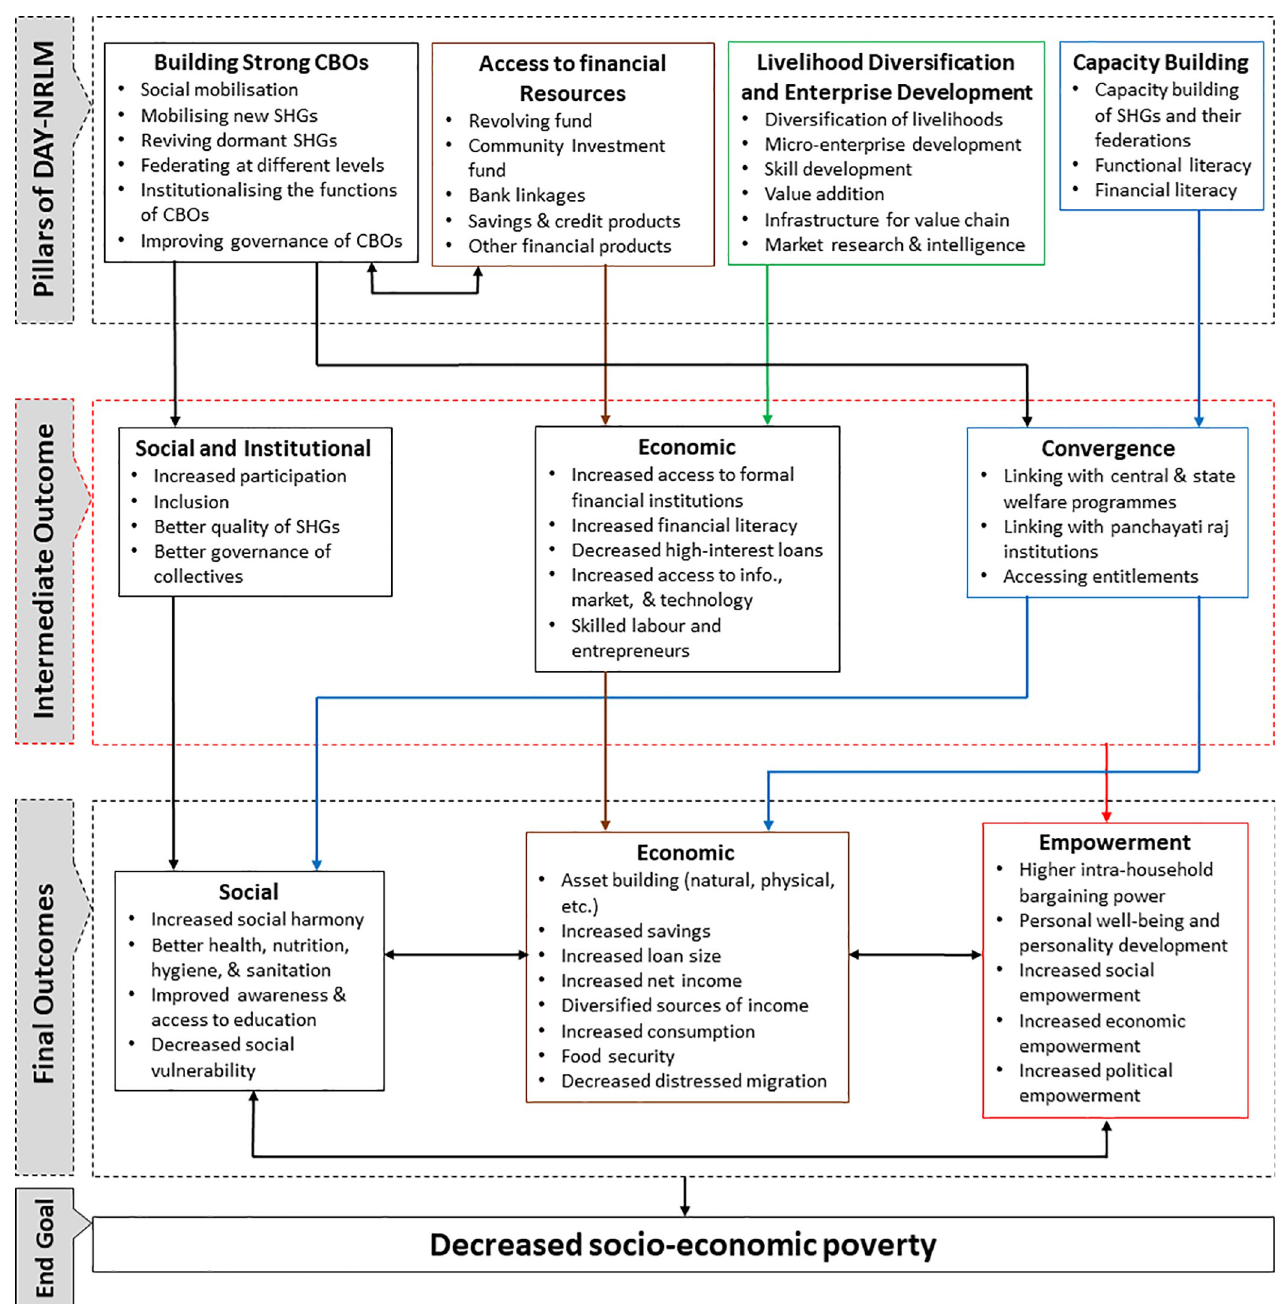
Fig 1. Theory of change for alleviation of socio-economic poverty in Jammu and Kashmir. This figure was developed in consultation with the programme implementers.